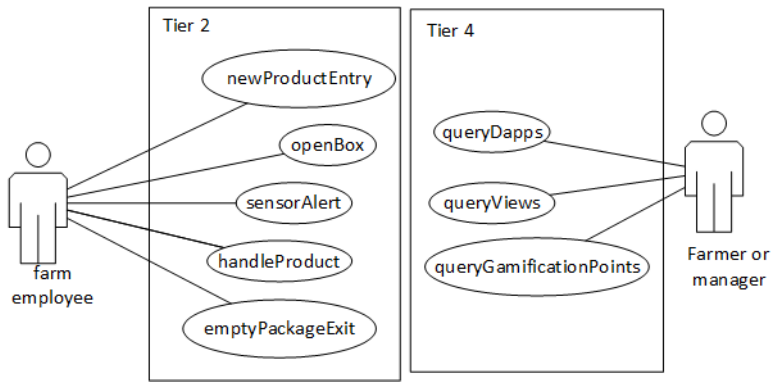
Figure 6. User interactions with the model.